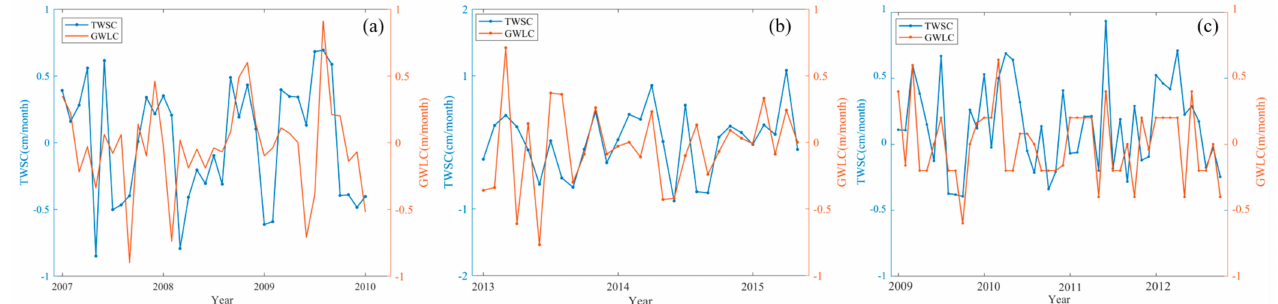
Figure 11. Comparison of measured GWLC and TWSC (( a ) Ganzhou Hotel station, ( b ) Zhangjiawei station, and ( c ) Yichun station).